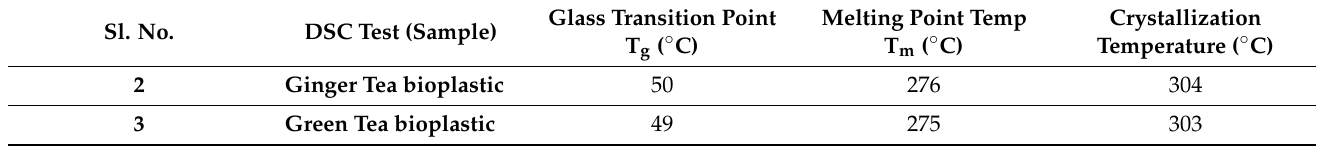
Table 5. DSC test results of bioplastics